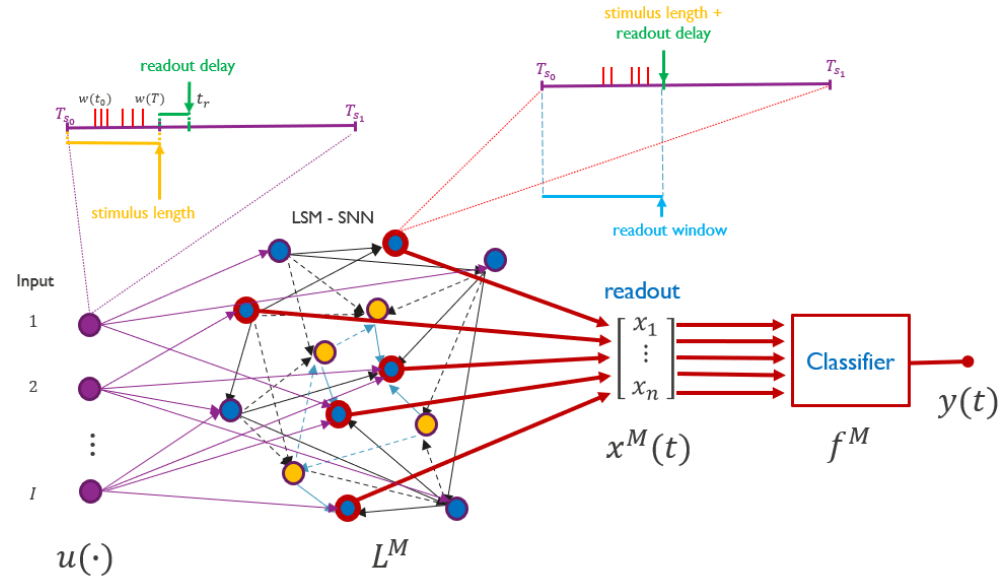
Figure 9. Schematic of the LSM given by x M ( t ) = ( L M u )( t ) and y ( t ) = f M ( x M ( t )) . T s interval a gesture is sampled in the LSM. While s i ( t 0 ) , s i ( t 0 + 1 ) , s i ( t 0 + 2 ) ,..., s i ( T ) are the individual spike events at input i . t r is the readout delay, and the readout windows gives the period which measures the state of the liquid, that is used as input to the